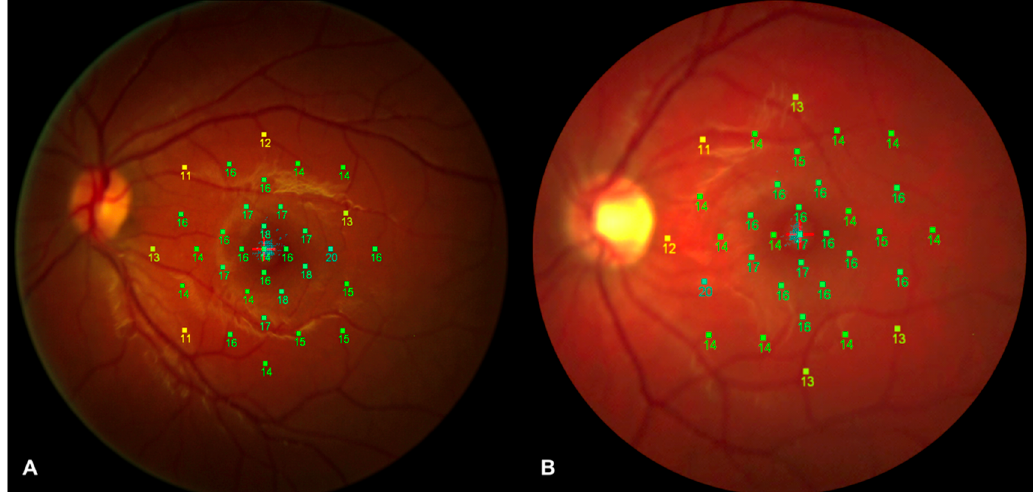
Figure 3. Microperimetry analysis of a diabetic patient and a healthy control subject. Retinal sensitivity map of a diabetic patient ( A ) and of a healthy control subject ( B ) registered along with a color fundus photograph. No significant difference in mean retinal sensitivity was disclosed between the two groups.